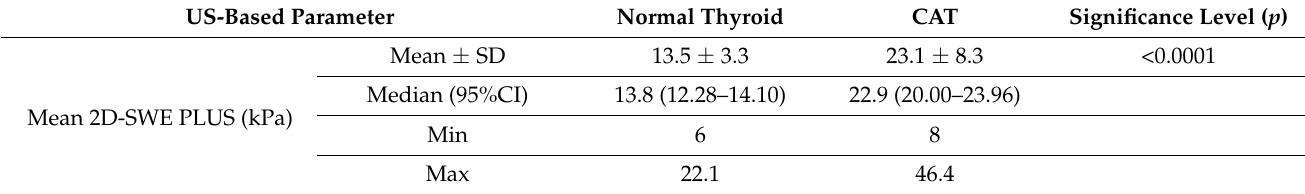
The values obtained for 2D-SWE based measurements are displayed in Table 2. Table 2. Viscosity and shear-wave measurements of patients with and without CAT.